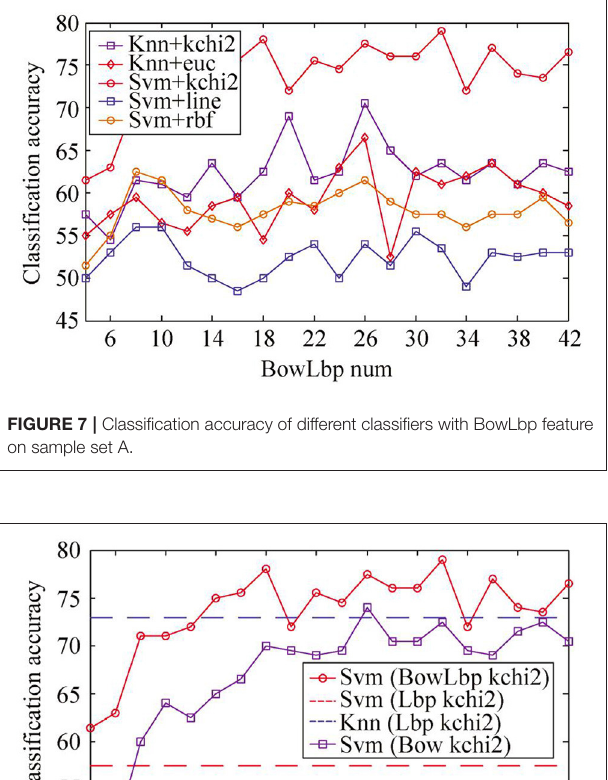
TABLE 1 | Faster RCNN, fast RCNN and RCNN comparison/%.